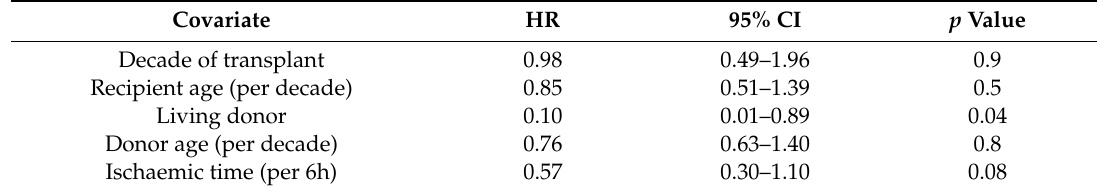
Table 3. Multivariate analysis for death-censored graft survival in 3rd + recipients.